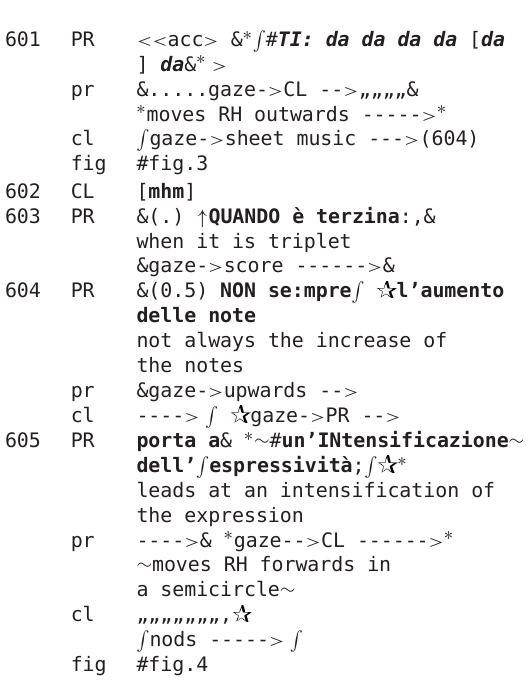
FIGURE 1 | Participation framework in the chamber music